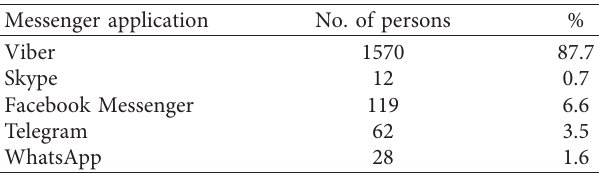
Table 5: Messenger applications used by Ukrainian IGSE ad- ministrators in their management